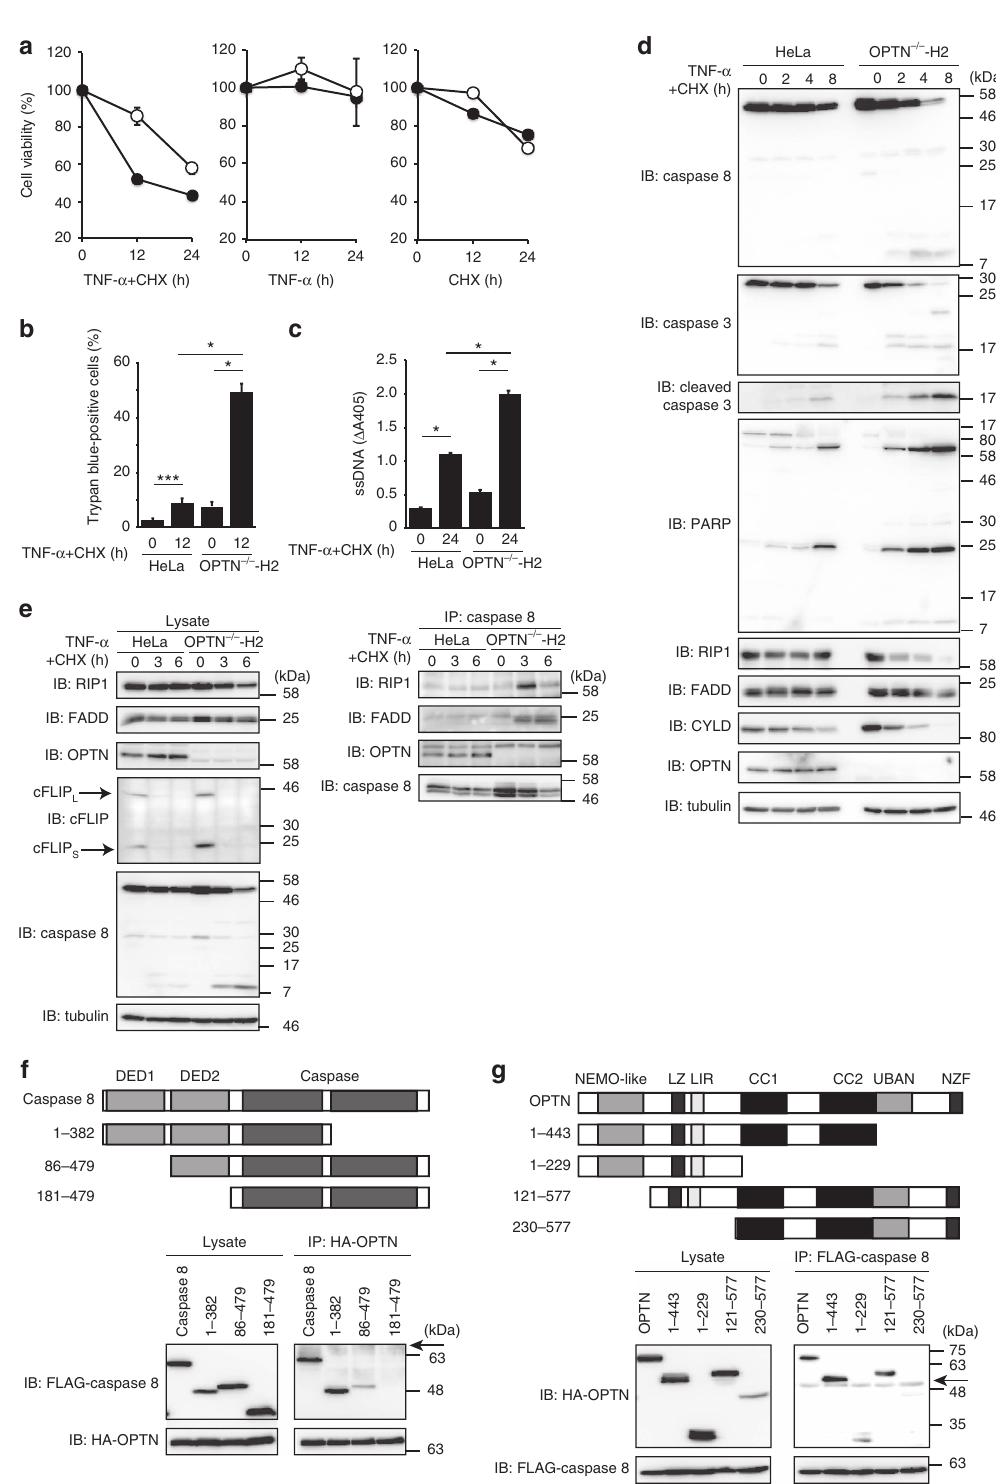
Figure 5 | OPTN suppresses TNF- a -induced apoptosis. ( a ) Accelerated cell death in TNF- a - and CHX-treated OPTN -KO HeLa cells. Cell survival assays were performed in the presence of TNF- a and/or CHX. Relative cell viabilities of WT (open circles) and OPTN -KO (filled circles) HeLa cells in the presence of TNF- a and/or CHX are indicated. Mean ± s.e.m. ( n ¼ 3). ( b ) Trypan blue exclusion assay. ( c ) ELISA for cytoplasmic histone-associated DNA fragments. ( b , c ) Mean ± s.e.m. ( n ¼ 3). Statistical significance was assessed using one-way analysis of variance. * P o 0.001, ** P o 0.01 and *** P o 0.05. ( d ) Enhanced cleavage of caspase 8, caspase 3 and PARP in TNF- a - and CHX-treated OPTN -KO HeLa cells. Immunoblotting of cell lysates, treated with TNF- a and CHX, was performed using the indicated antibodies. ( e ) Enhanced TNFR complex II formation in TNF- a - and CHX-treated OPTN -KO cells. Cells were treated with TNF- a and CHX for the indicated times, and cell lysates and anti-caspase 8 immunoprecipitates were immunoblotted by the indicated antibodies. ( f , g ) Identification of interacting regions between caspase 8 and OPTN. Co-immunoprecipitation experiments were performed using various mutants of caspase 8 ( d ) and OPTN ( e ). Arrows, nonspecific